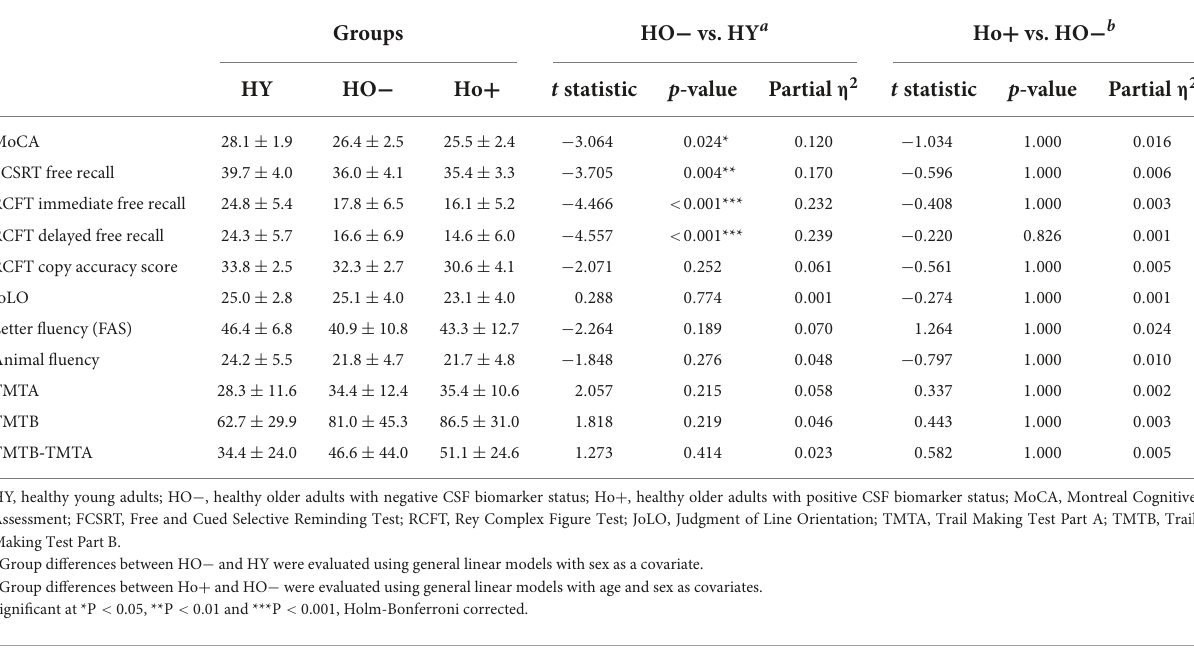
partial η 2 = 0.217], and V iso [the subiculum: t (82) = 4.824,